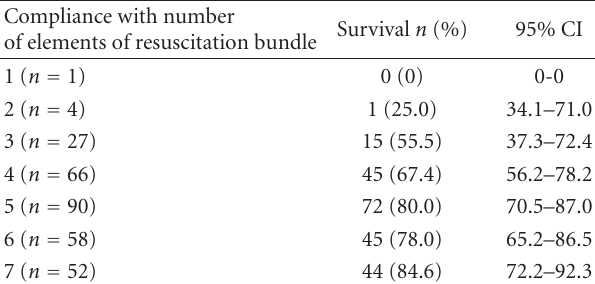
Table 3: Association between the increasing number of resuscita- tion bundle elements compliance and the survival in both